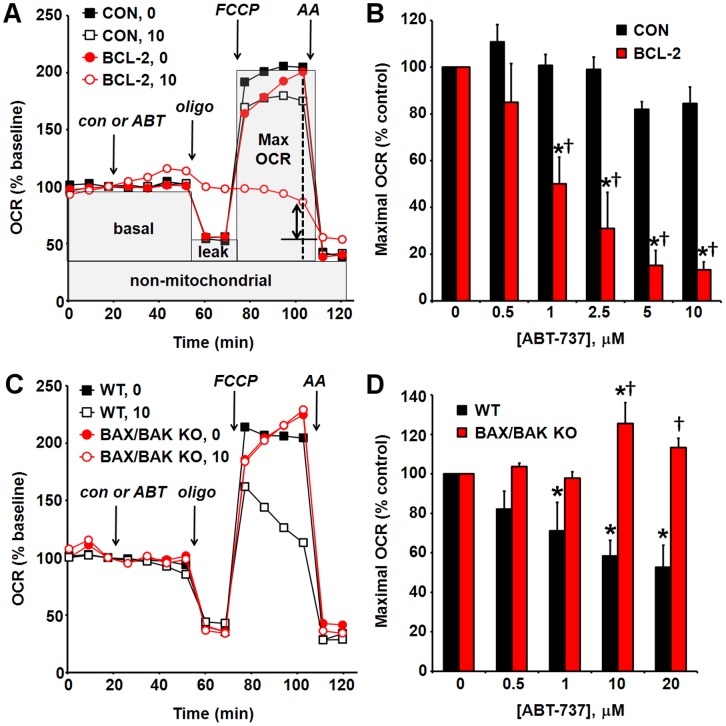
ABT-737 induces a BAX/BAK-dependent impairment of maximal O2 consumption rate in sensitive cells.(A) Representative bioenergetic profiles of MCF10A control-transfected (CON) and BCL-2 overexpressing (BCL-2) cells treated with vehicle (con) or ABT-737 (ABT, 10 µM), oligomycin (oligo, 0.5 µg/ml), FCCP (1 µM), and antimycin A (AA, 10 µM) as indicated. Pyruvate (10 mM) was added in combination with FCCP to ensure that substrate supply was not rate-limiting for maximal O2 consumption. The dotted line indicates the time point used to calculate maximal OCR. The solid line with arrows illustrates the reduction in MCF10A BCL-2 maximal OCR with ABT-737. Representative traces are means from one experiment performed in triplicate. OCR is baseline-normalized to the point prior to vehicle or ABT-737 addition. (B) Maximal OCR following addition of ABT-737 as % vehicle control (see A). Results are mean ± SE of 3–4 experiments with 2–5 replicates per experiment. *p<0.05 for ABT-737-treated relative to control-treated; †p<0.05 for MCF10A BCL-2 relative to control-transfected cells. (C) Representative bioenergetic profiles of immortalized wild type (WT) and BAX/BAK knockout (KO) mouse embryonic fibroblasts (MEF) treated with vehicle (con) or ABT-737 (ABT, 10 µM), oligo (0.2 µg/ml), FCCP (1 µM, WT, 2 µM KO), and AA (1 µM) as indicated. Traces are means from one experiment with 4–5 replicates. OCR is baseline-normalized as in A. (D) Maximal OCR following addition of ABT-737 as % vehicle control. Results are mean ± SE of 3 experiments with 2–5 replicates per experiment. Maximal OCR was determined as in A and B. Optimal oligomycin and FCCP concentrations were determined by titration for each cell type. *p<0.05 for ABT-737-treated relative to control-treated; †p<0.05 for BAX/BAK KO MEF relative to WT.